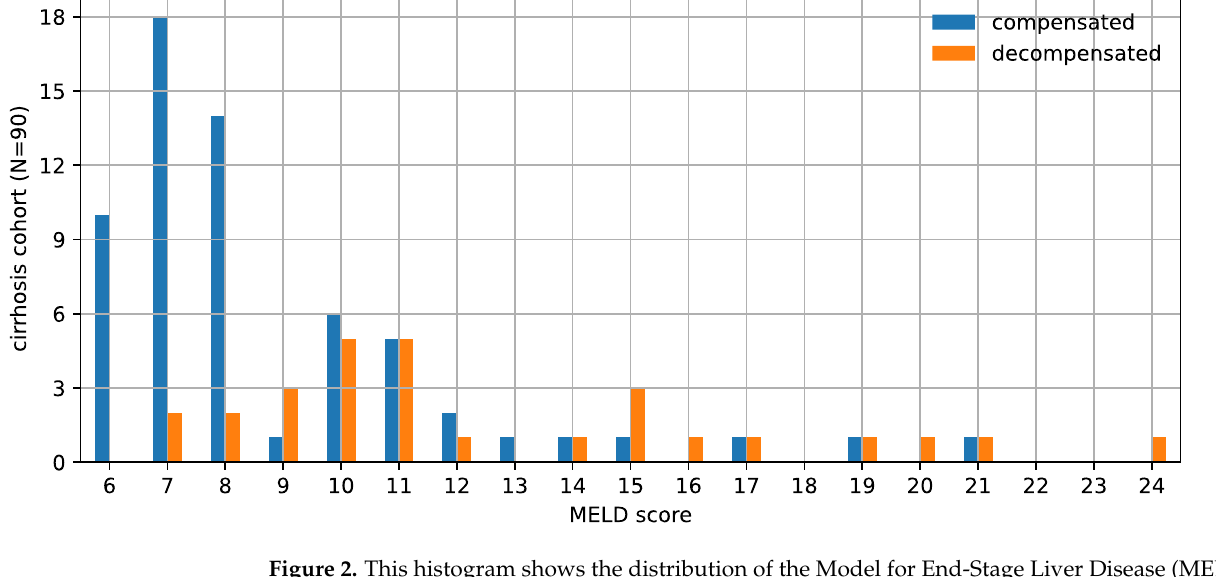
Figure 2. This histogram shows the distribution of the Model for End-Stage Liver Disease (MELD) score and decompensation status of the cirrhosis cohort. This cohort population is biased towards relatively milder liver disease. The imperfect correlation between MELD score and decompensation status is also evident from this chart.